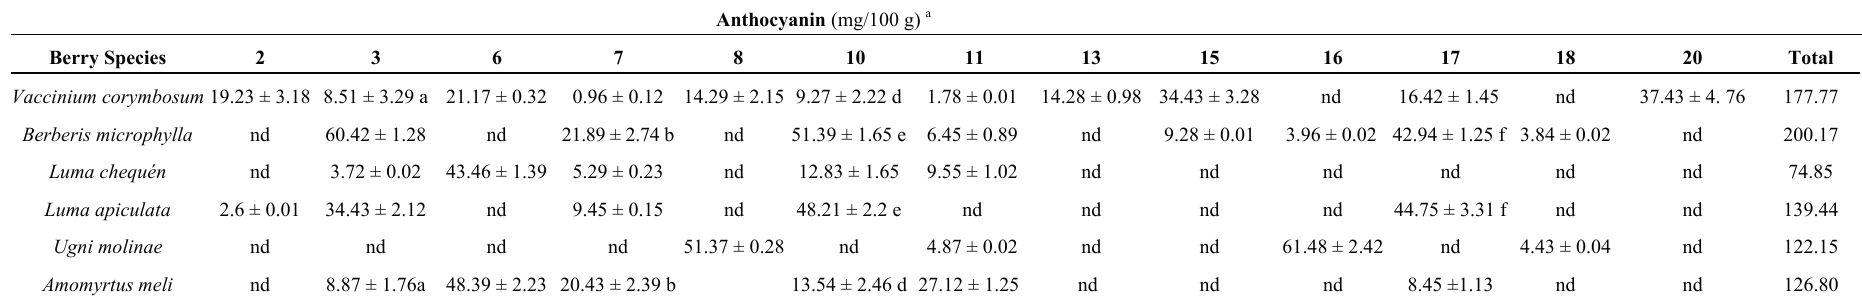
Table 3. Major anthocyanins quantified by HPLC-DAD in six edible berry fruits from the VIII Region of Chile. Anthocyanin (mg/100 g) a